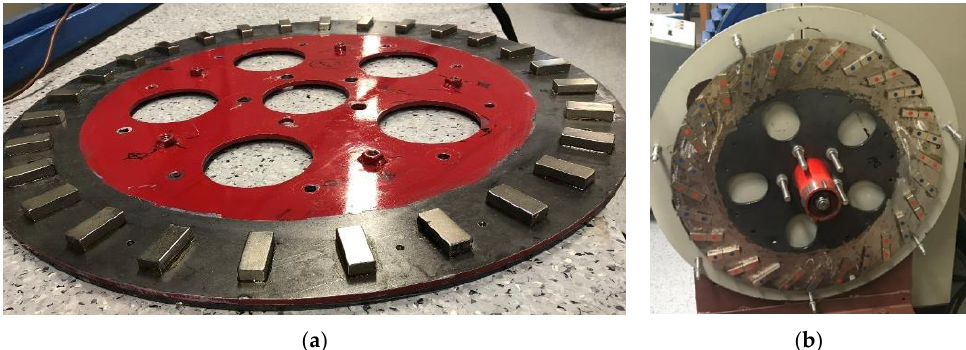
Figure 18. Stator disk.